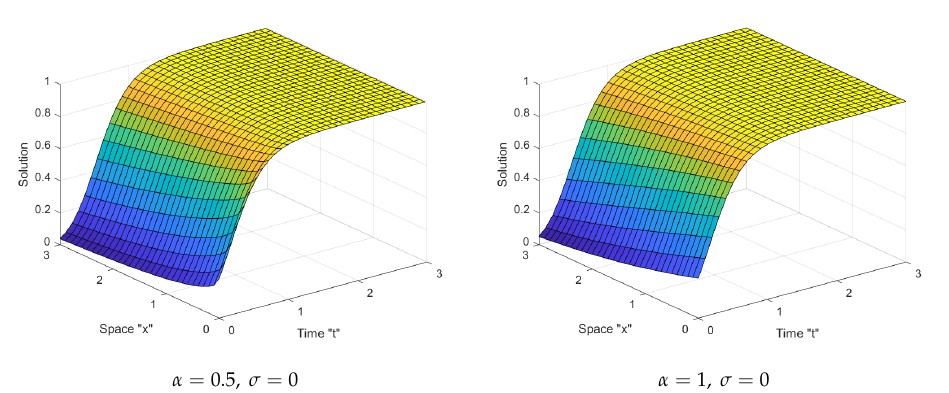
Figure 1. 3D shapes of the solution (14) for σ = 0 and α = 0.5,1. From Figure 2: we observe that after embedding noise and increasing its strength by σ = 1, 2, the surface becomes significantly flatter after minor transit